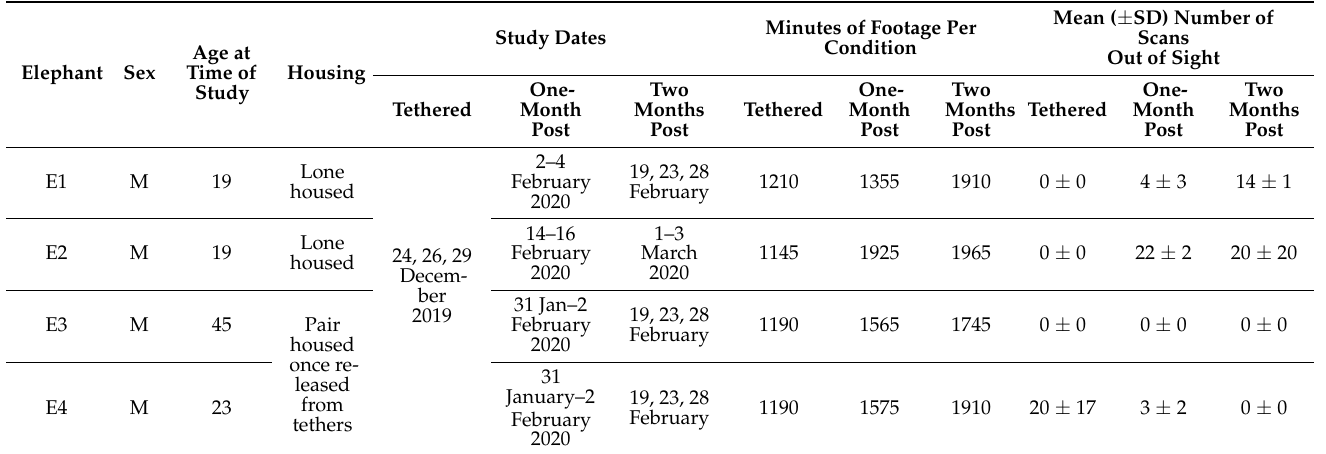
Table 1. Details of study subjects and periods of data